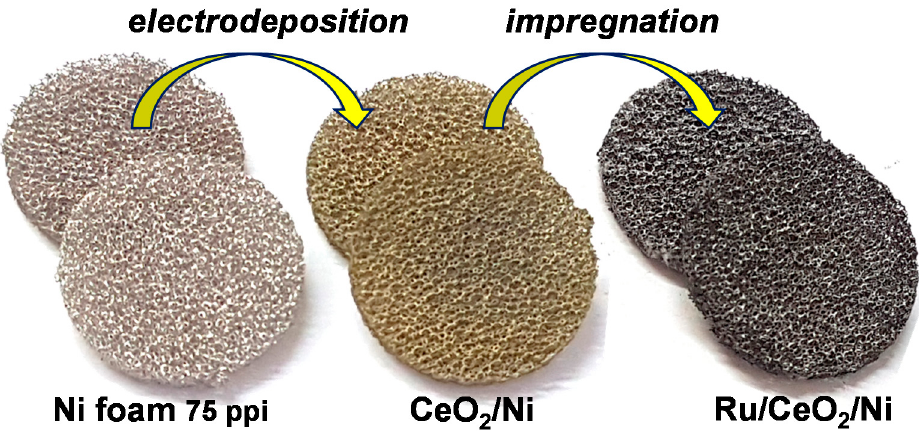
Figure 1. Images of the structured catalysts prepared starting from commercial Ni open cell foam disks with 75 pores per inch (ppi), via CeO 2 electroprecipitation and impregnation with Ru. Table 1. Composition, specific surface area (S.S.A.), and H 2 consumption during temperature programmed reduction (TPR) experiments of the investigated foam catalysts.